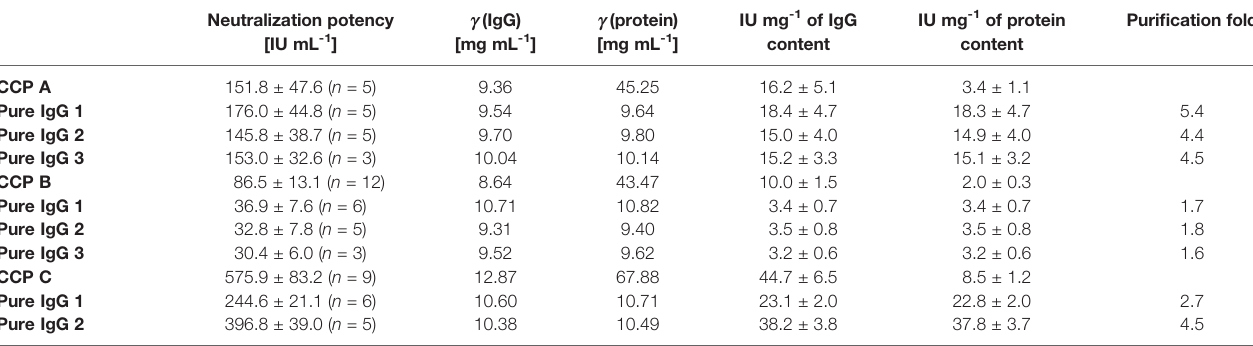
TABLE 4 | Comparison of neutralization potencies of the COVID-19 convalescent plasma (CCP A-C) and the corresponding pure IgG preparations determined by the wild-type SARS-CoV-2 ED 50 assay, together with their speci fi c activities.